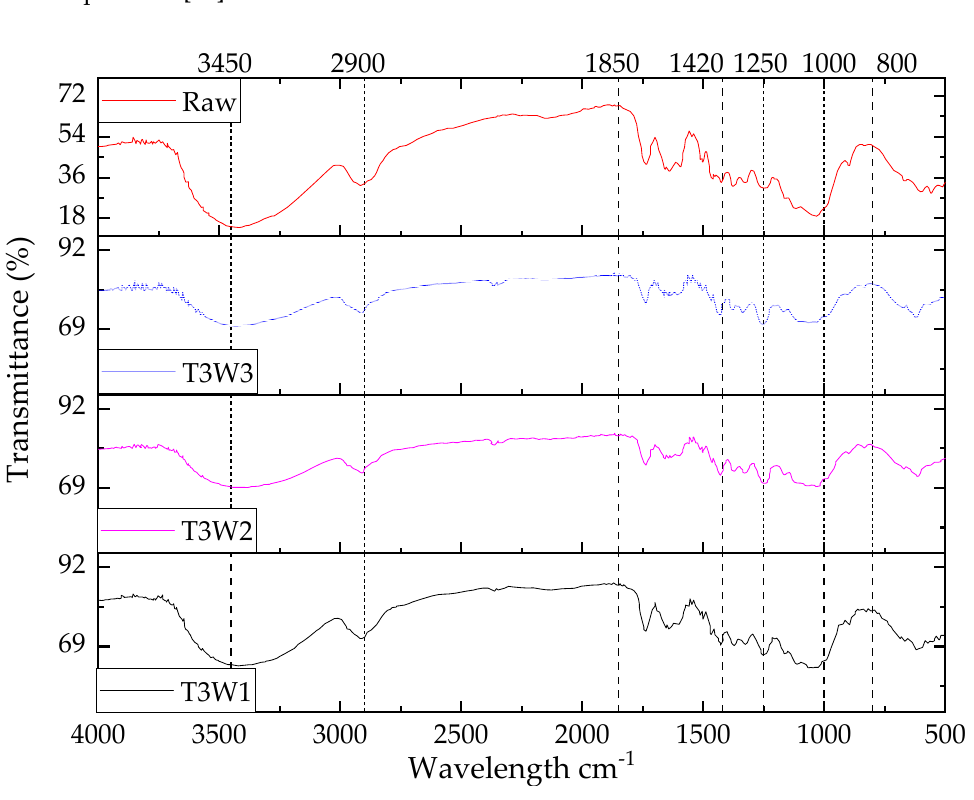
Figure 12. FTIR transmission spectra of water retardant (T3)-treated jute fibers.